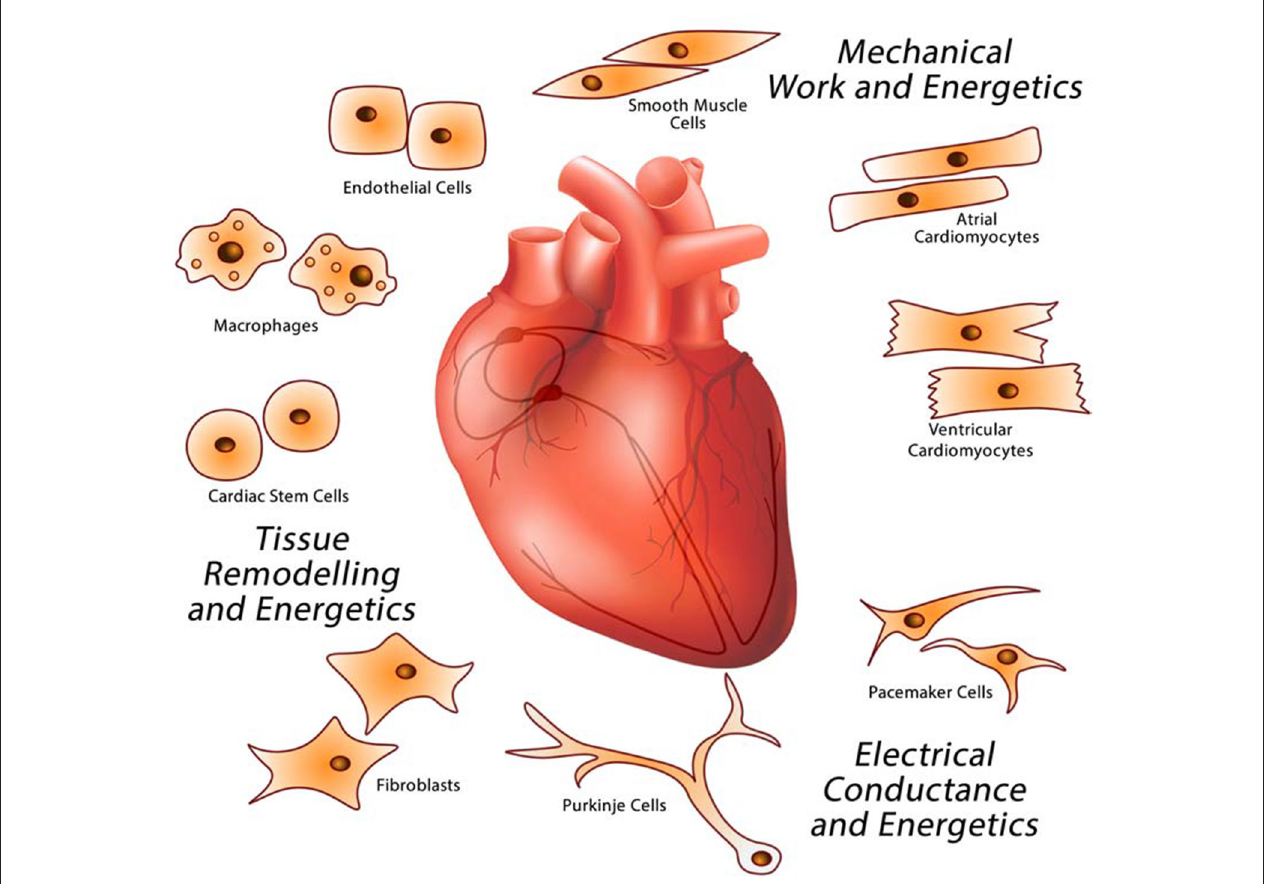
FIGURE 1 | Major cardiac cell types that make up the heart. The heart is a multicellular organ comprised of different cell types responsible for providing specific functions related to electrical conductance (macrophages, pacemaker, and Purkinje cells), mechanical work (cardiomyocytes), and tissue remodeling (endothelial cells, fibroblasts, macrophages, and stem